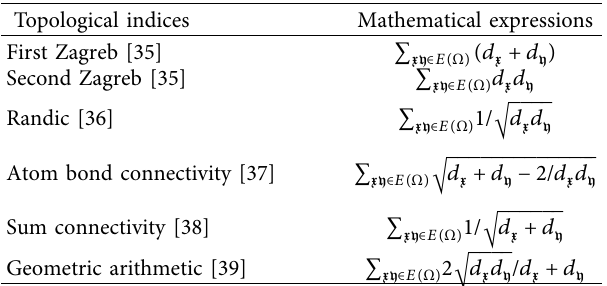
Table 2: Degree-based topological